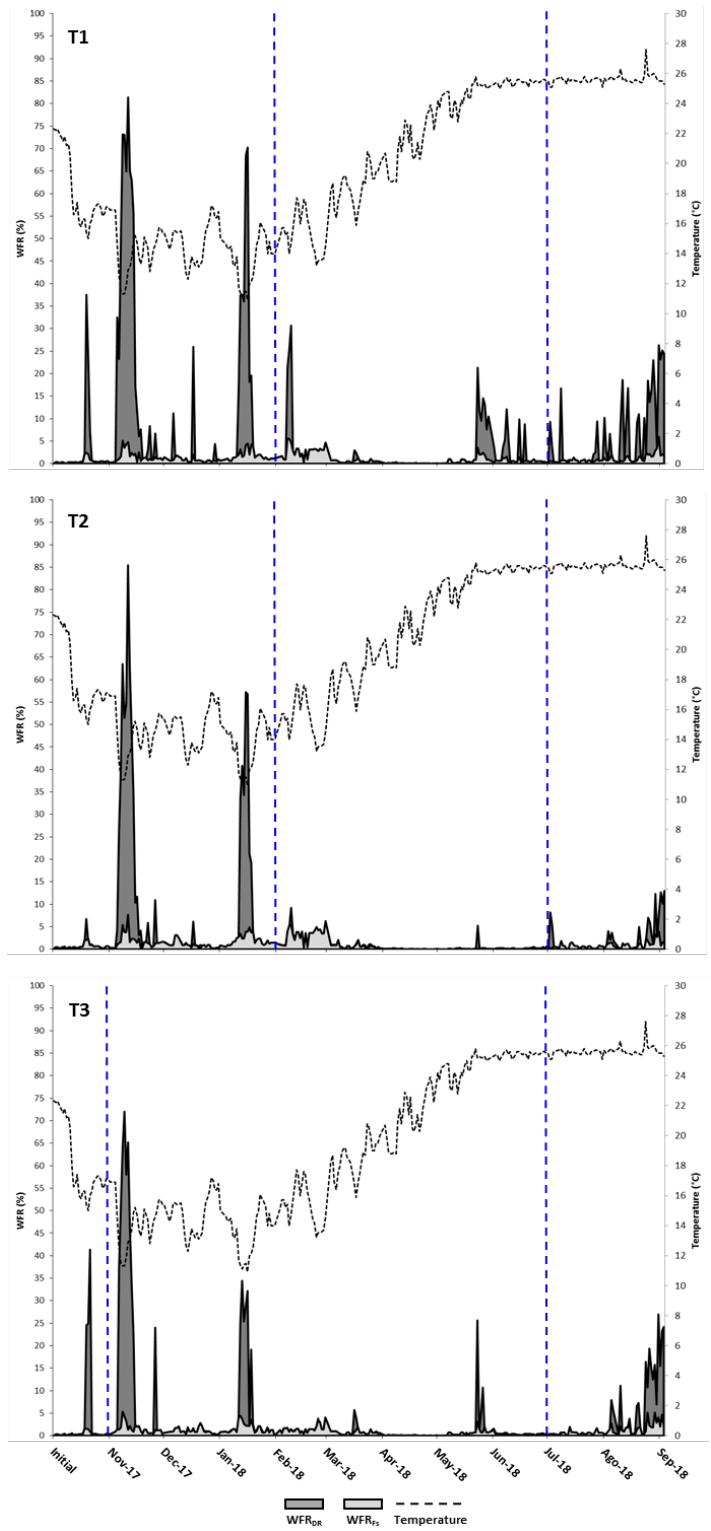
Figure 8. Daily mean values of WFR DR and WFR Fs in each feeding treatment throughout the trial and water temperature. Vertical blue dotted lines indicate the dates of change of feed type.